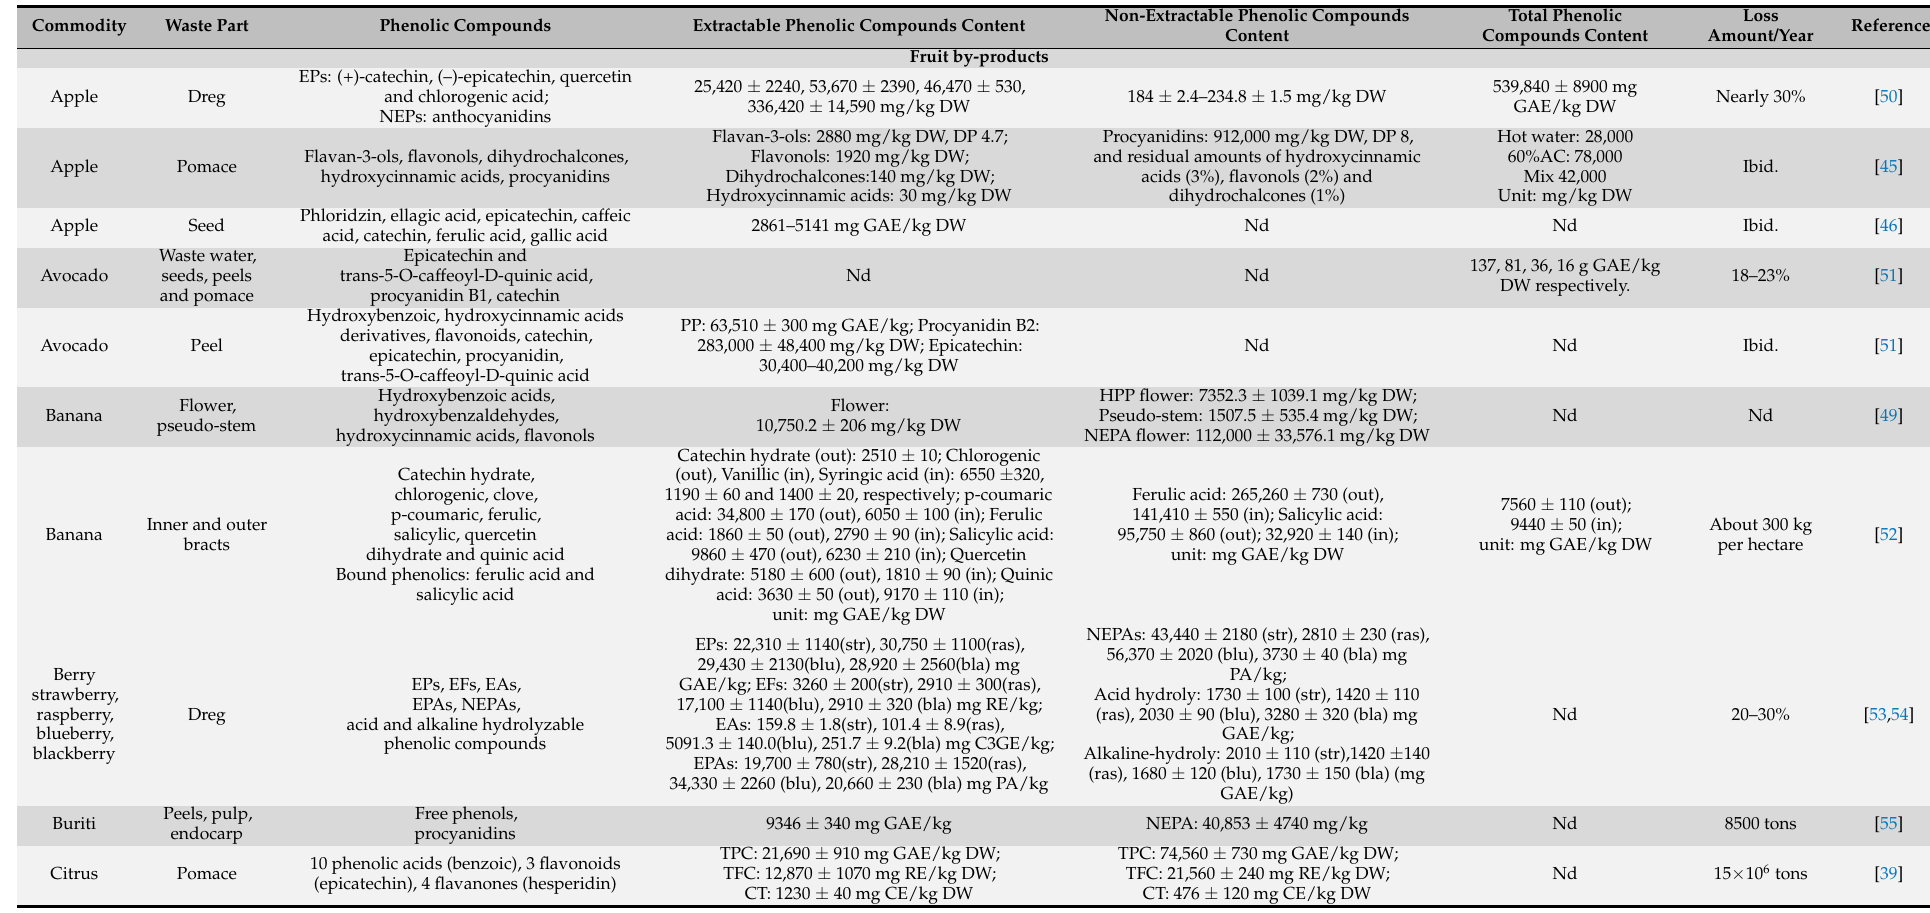
Table 1. Total, extractable, and non-extractable phenolic compounds contents in the waste of different fruit and